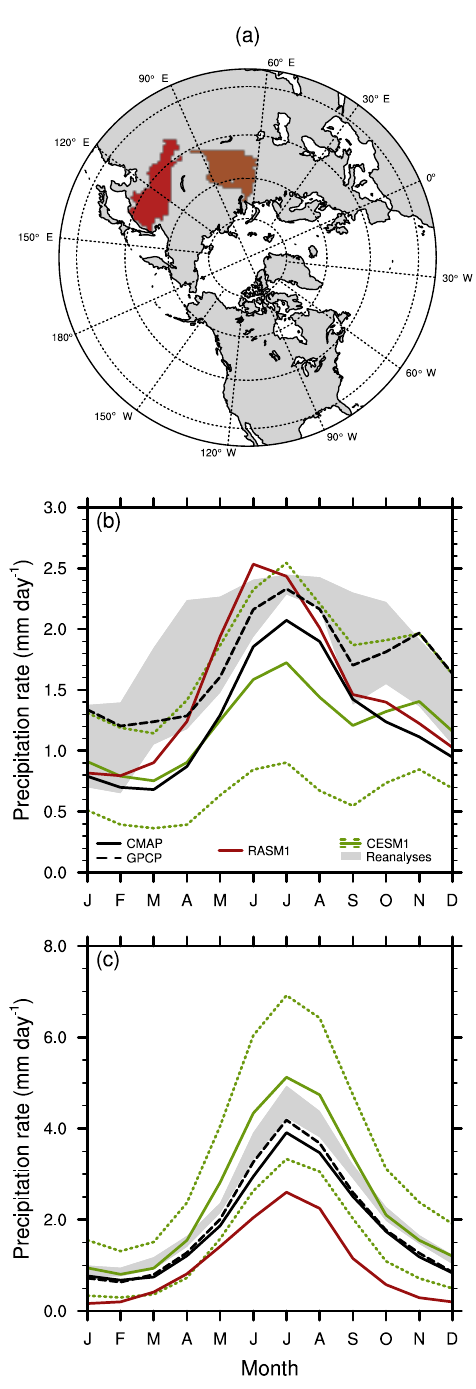
Figure 3. (a) The Ob (brown) and Amur (red) River basins, with re- gional mean precipitation from CMAP (solid black), GPCP (dashed black), RASM1 (red), and CESM1 (green) along with the reanaly- sis spread (gray shading) over the Ob basin in (b) and the Amur basin in (c) . The green dotted lines surrounding CESM1 indicate the ensemble maximum and minimum